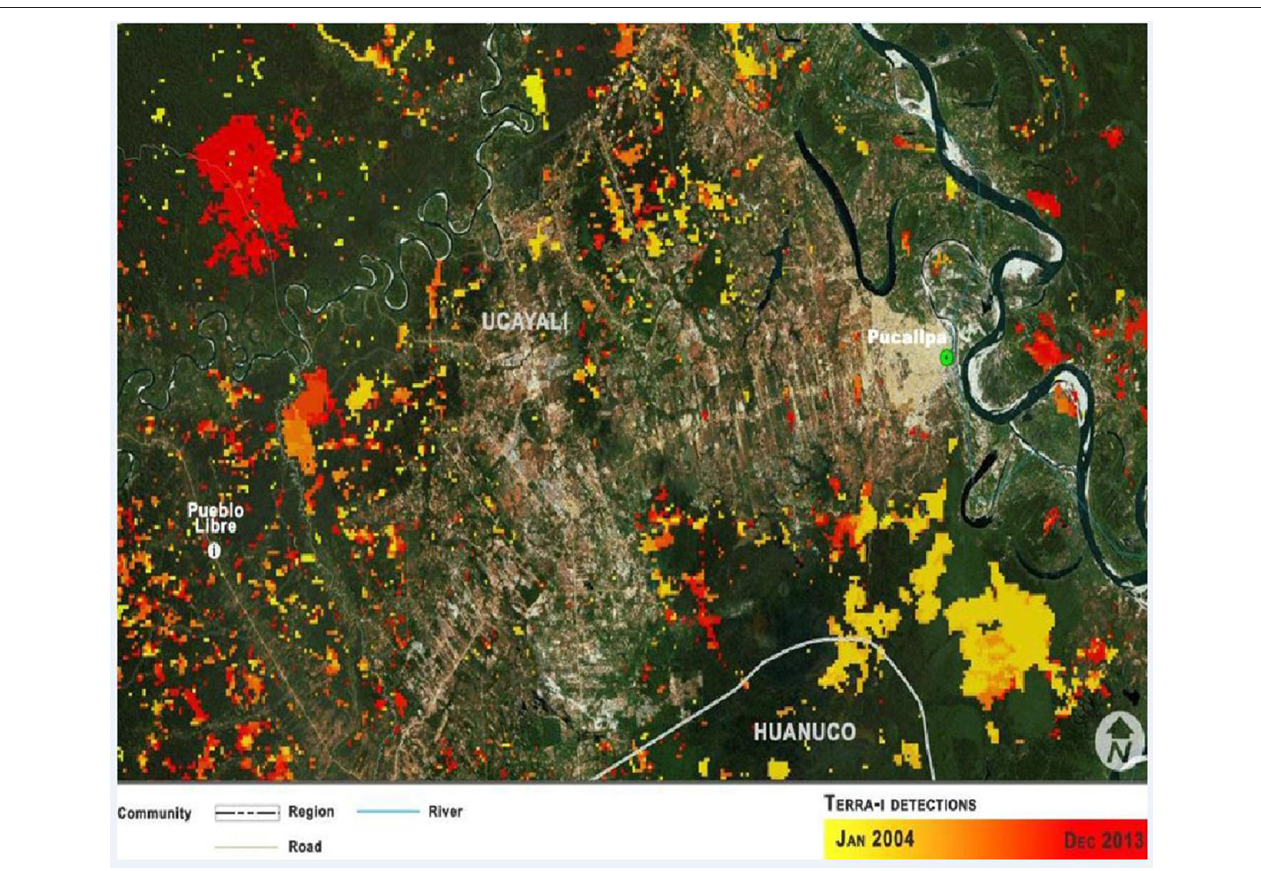
FIGURE 2 | Location of the mestizo village Pueblo Libre, in the Ucayali department, Peruvian Amazon. The map indicates the changes in land use from January 2004 to December 2013 in a color gradient, according to Terra-i (CIAT, 2015). The map also shows the deforestation that occurred before 2004 along the Federico Basadre highway and surrounding roadsides. Source: Terra-i; map prepared by Paula